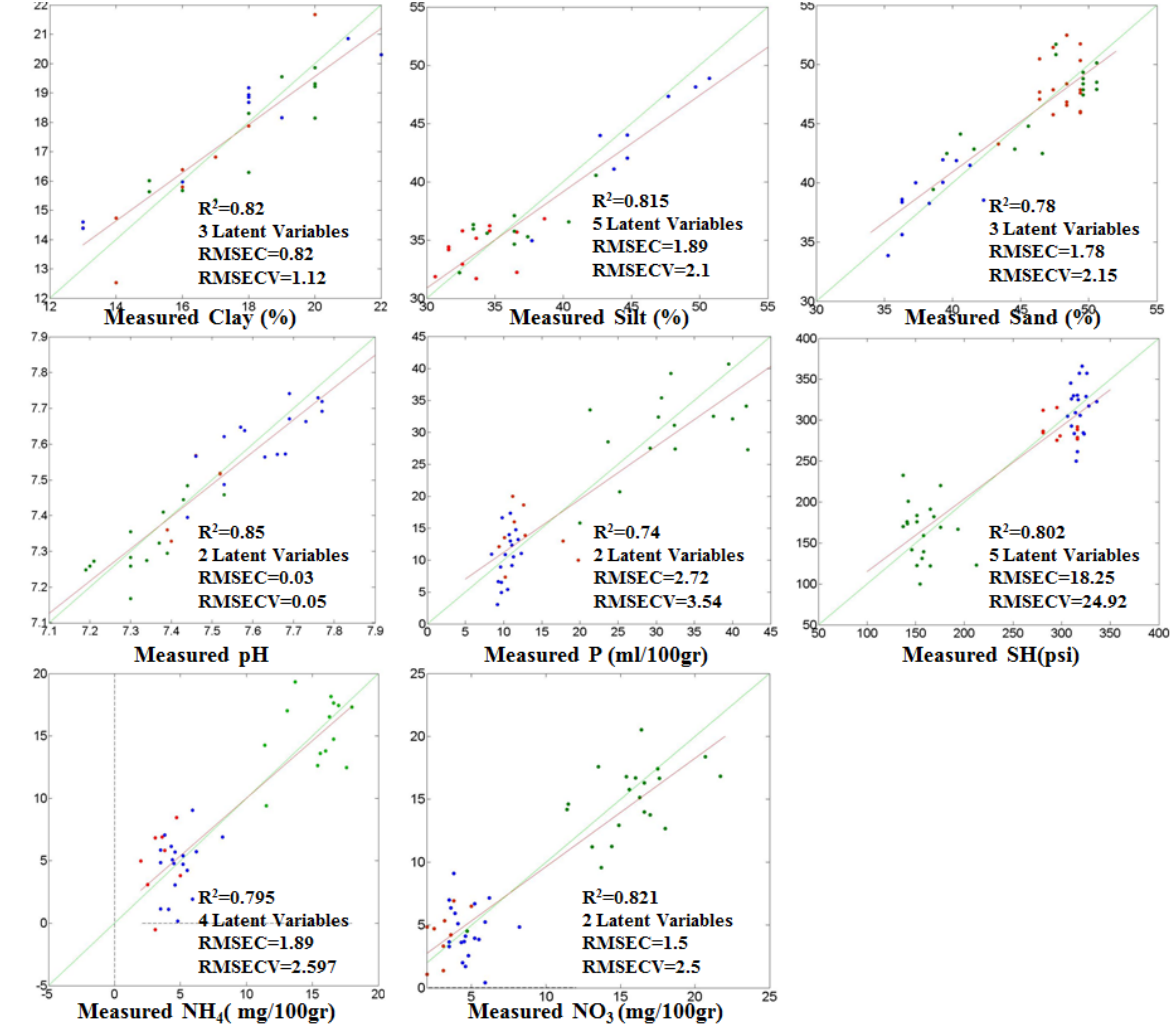
Figure 6. Scatterplots of cross-validation (CV) predicted values versus measured values for several soil properties for the calibration dataset for all land uses in the Migda site, Israel. Calibration models were developed with a partial least squares-regression (PLS-R). RMSEC: root mean square error of calibration; RMSECV: root mean square error of cross-validation; P: phosphorus p; NH 4 : ammonium; NH 3 : nitrate, SH: surface hardness. The colors of the spots represent land-use types: abandoned field with grazing (blue), abandoned field with no grazing (red), agro-pastoral grazing